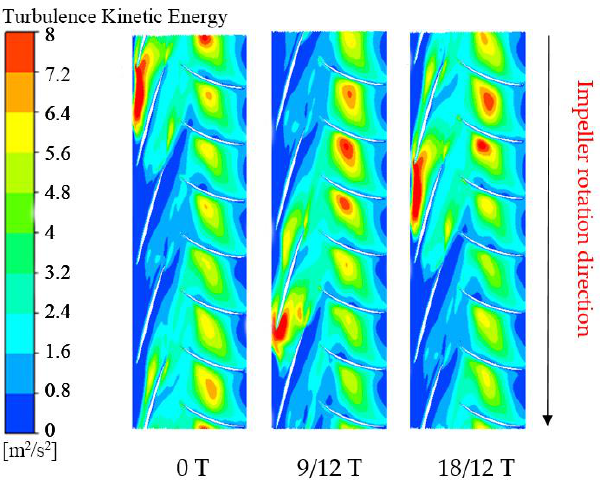
Figure 11. Turbulent kinetic energy of impeller and guide vane on the plane at 95% of span ( δ = 0.2 mm).